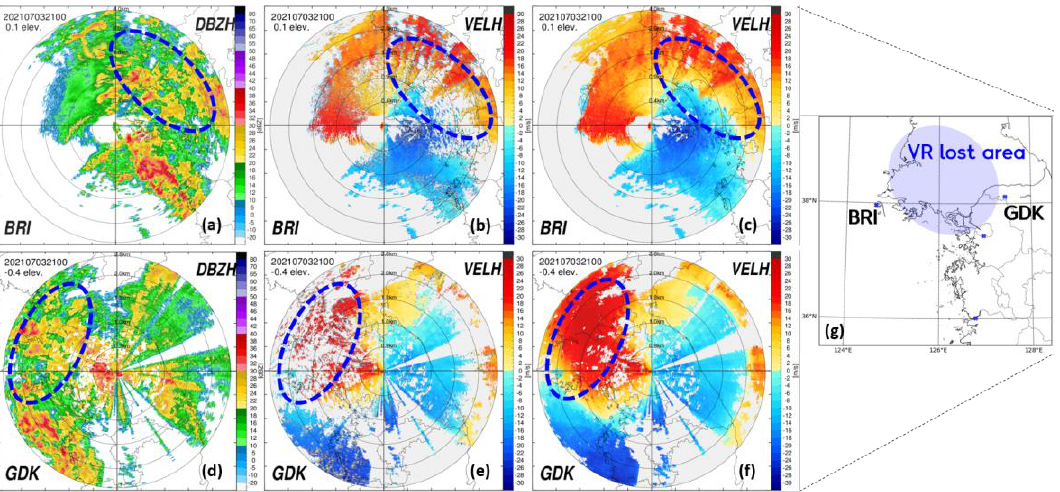
Figure 12. PPIs at the lowest elevation angles of (top) BRI and (bottom) GDK at 2100 LST on July 2021; ( a , d ) radar reflectivity, ( b , e ) raw radial velocity, ( c , f ) radial velocity after quality control, and ( g ) the simultaneously lost area of the radial velocities at both BRI and GDK.